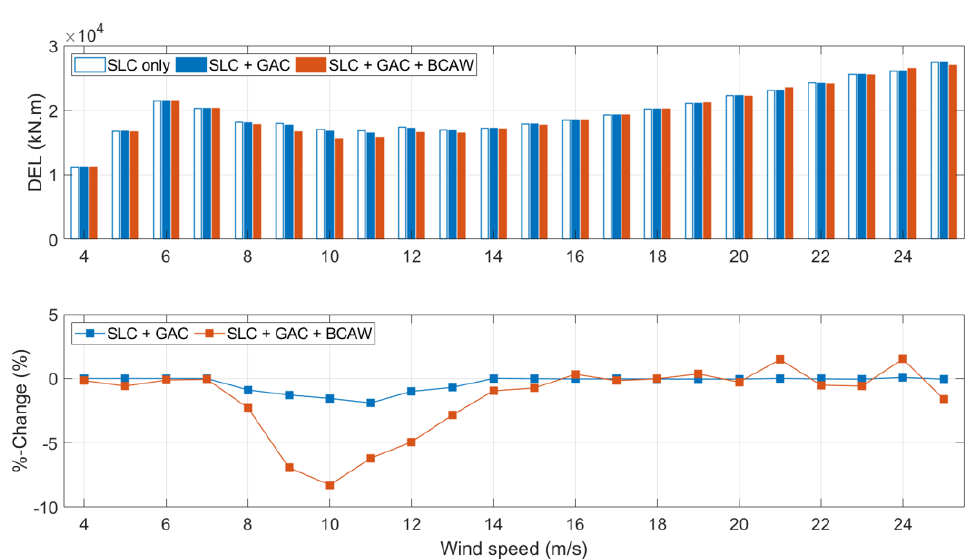
Figure A6. Variation of the DELs of the tower base fore-aft bending moments from cut-in to cut-out wind speed under DLC 1.2 with different control architectures. Top—Dimensional DELs; Bottom— Percentage changes with respect to the ‘SLC Only’ case.